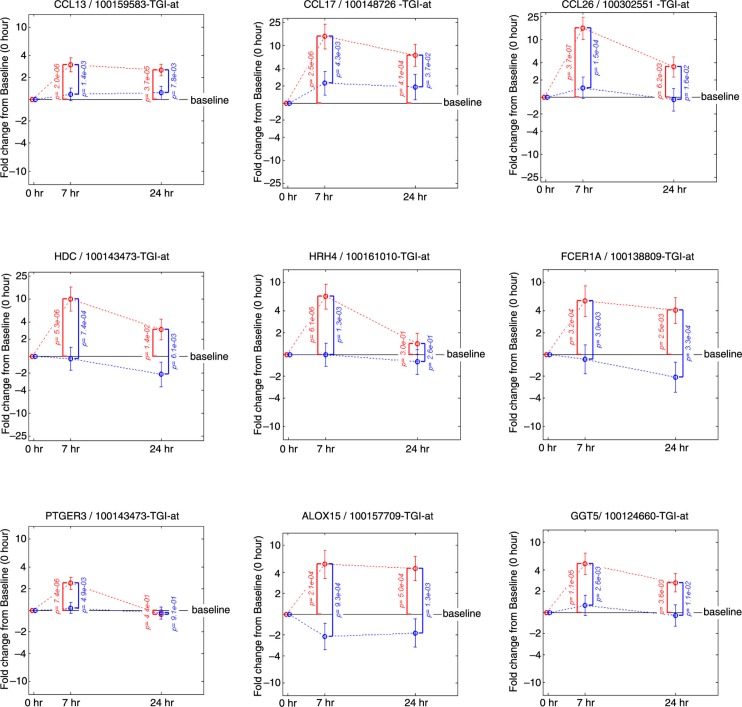
Fold change from baseline in gene expression. Inflammatory chemokines (CCL13, CCL17, CCL26), molecules controlling the release of histamine (HDC, HRH4, FCER1A) prostaglandins and leukotrienes (PTGER3, ALOX15, GGT5). Fold change from baseline for the placebo group is represented in red. Fold change from baseline for the fluticasone group is represented in blue. p Values are adjusted p values; error bars represent 90% confidence intervals.